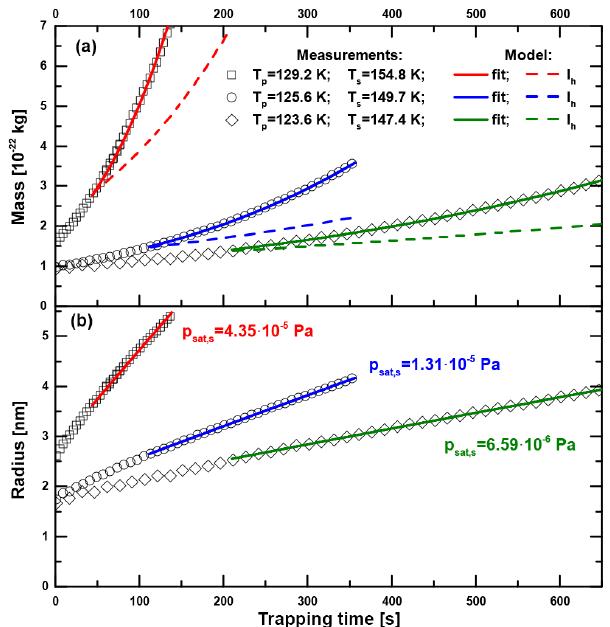
Figure A1. Particle mass (a) and radius (b) as a function of trapping time in MICE for three exemplary measurements with sample sur- face temperatures T s of 147.4K ( ♦ ), 149.7K ( ◦ ) and 154.8K ( (cid:3) ). The particle temperatures T p are between 123 and 130K, ensur- ing saturations above 1000. The green, blue and red curves show the results of numerically fitting p sat , s in Eq. (A2) to the data. The dashed colored lines show the expected growth curves when assum- ing hexagonal ice I h